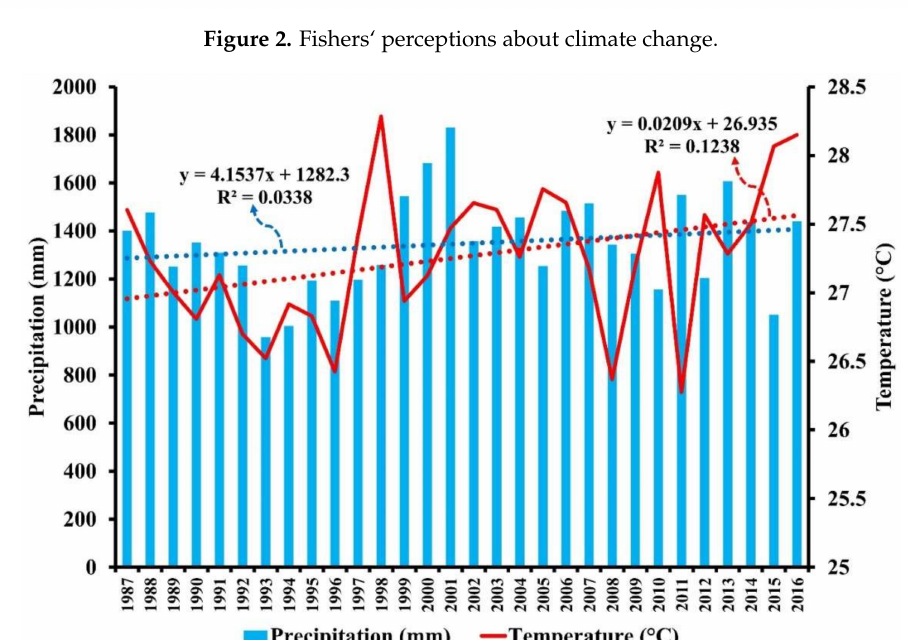
Figure 3. Precipitation and temperature trends over the past 30 years